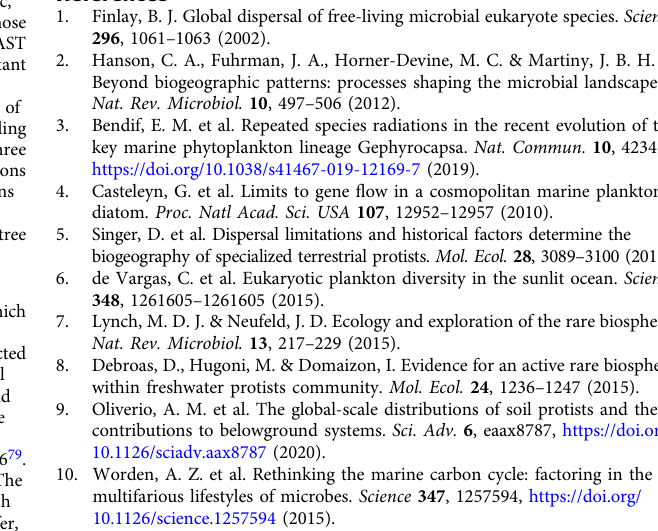
Figshare under https://doi.org/10.6084/m9. fi gshare.7845167. Other relevant data supporting the fi ndings of the study are available in the Supplementary